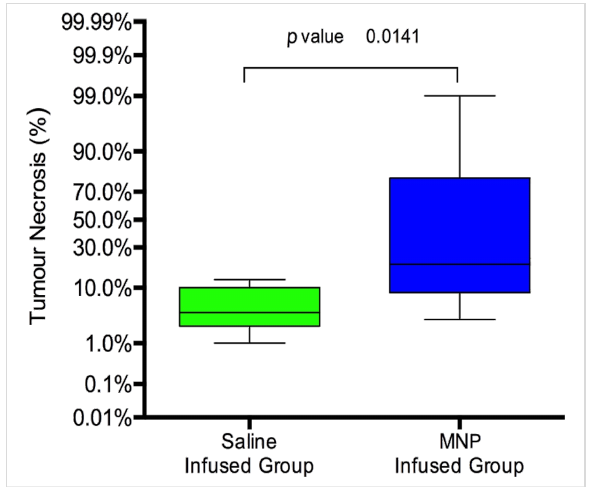
Figure 6: Error bars show the percentages of tumor necrosis in rats infused with saline or magnetic nanoparticles. A significant difference can be observed between the two groups of rats ( p =